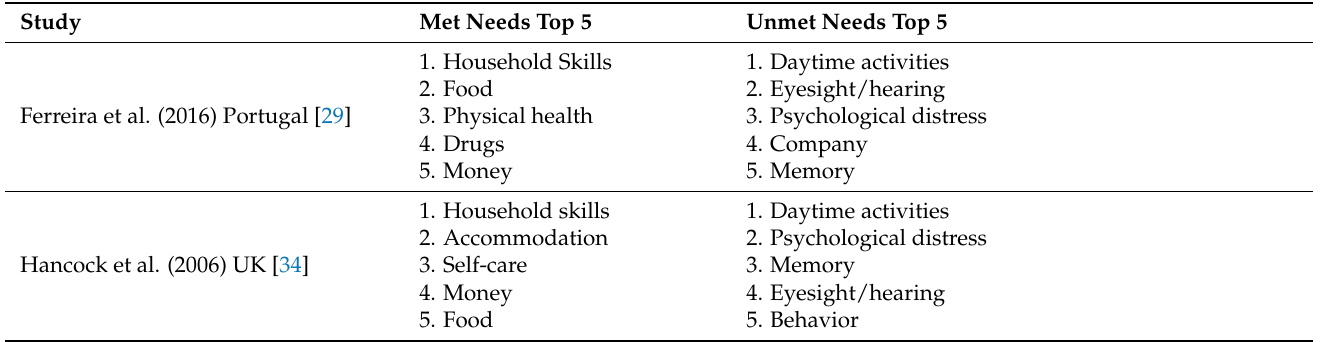
Table 4. Outcomes CANE